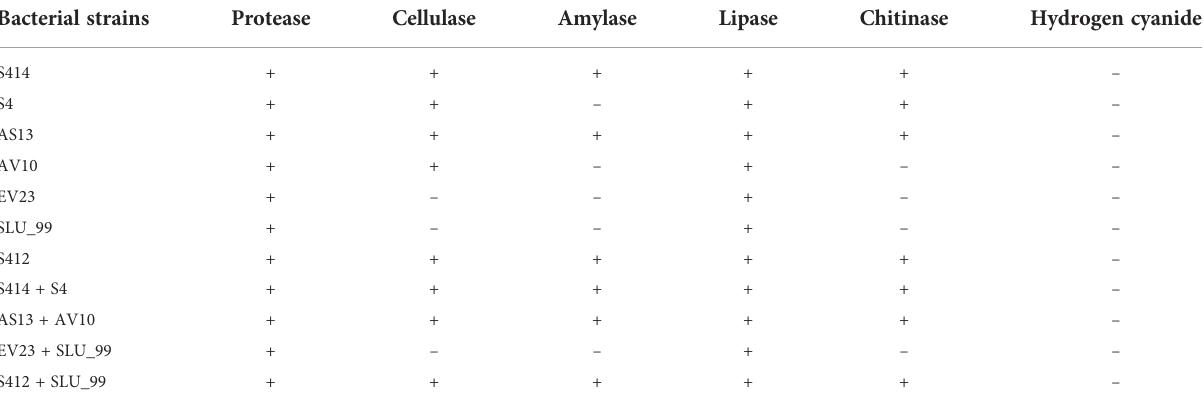
TABLE 2 In vitro production of various lytic enzymes by candidate biocontrol bacteria. Bacterial strains Protease Cellulase Amylase Lipase Chitinase